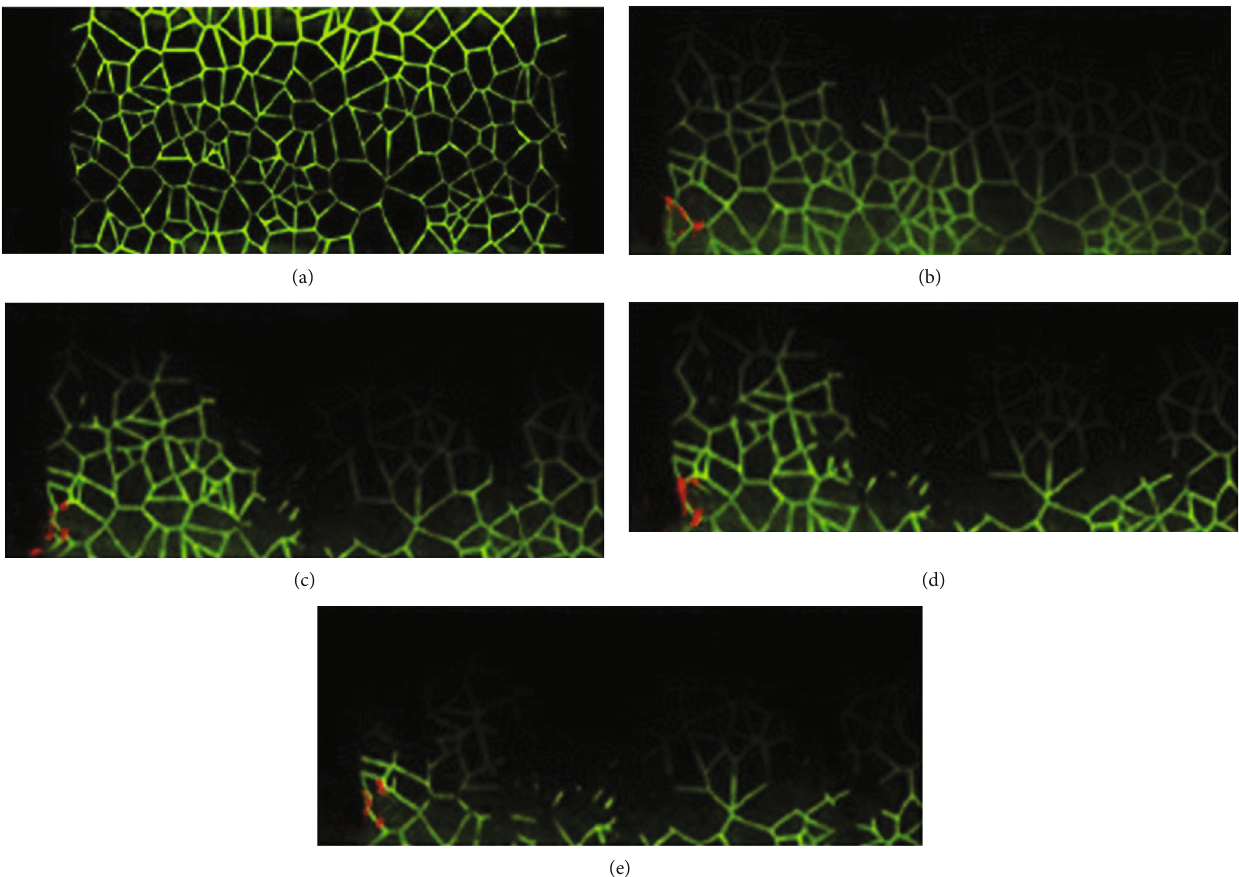
Figure 7: Oil recovery under di ff erent injecting pressure from a through e: 130, 140, 155, 183, 195 psig, respectively [89].